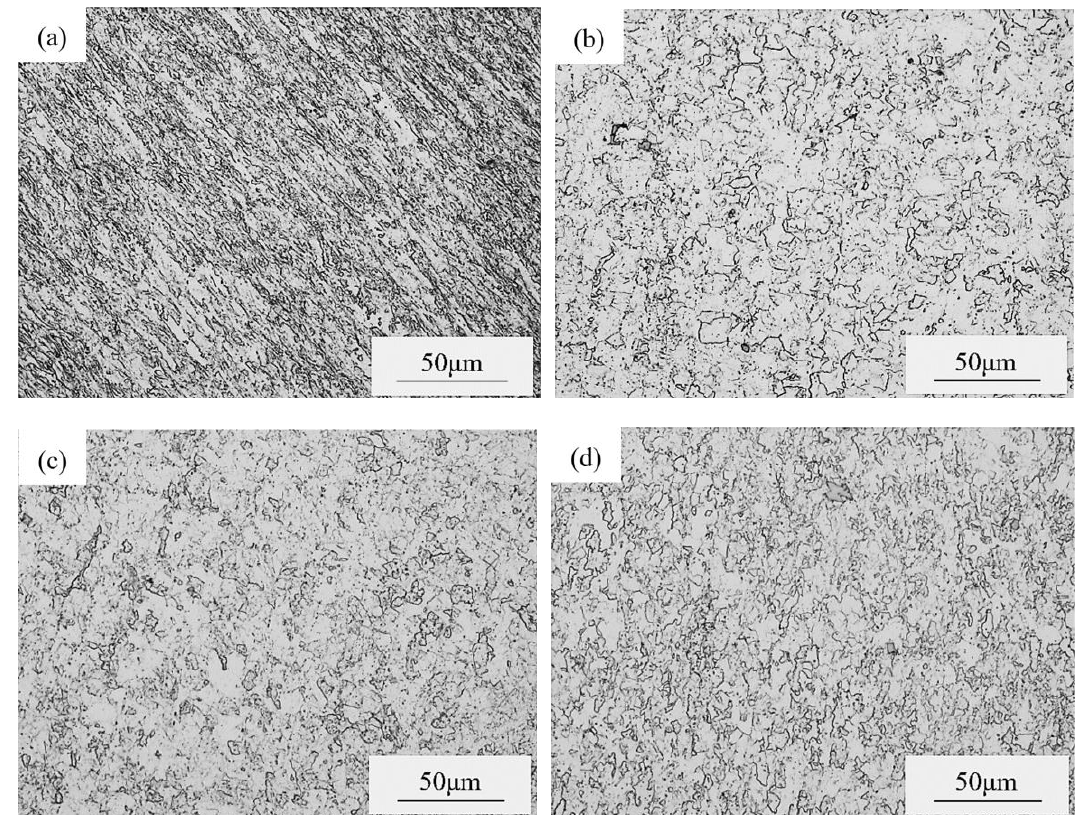
Figure 7. Optical micrographs of the low-carbon ferritic stainless steel samples deformed at the different temperatures: ( a ) 700 °C, ( b ) 800 °C, ( c ) 900 °C, ( d ) 1000 °C.